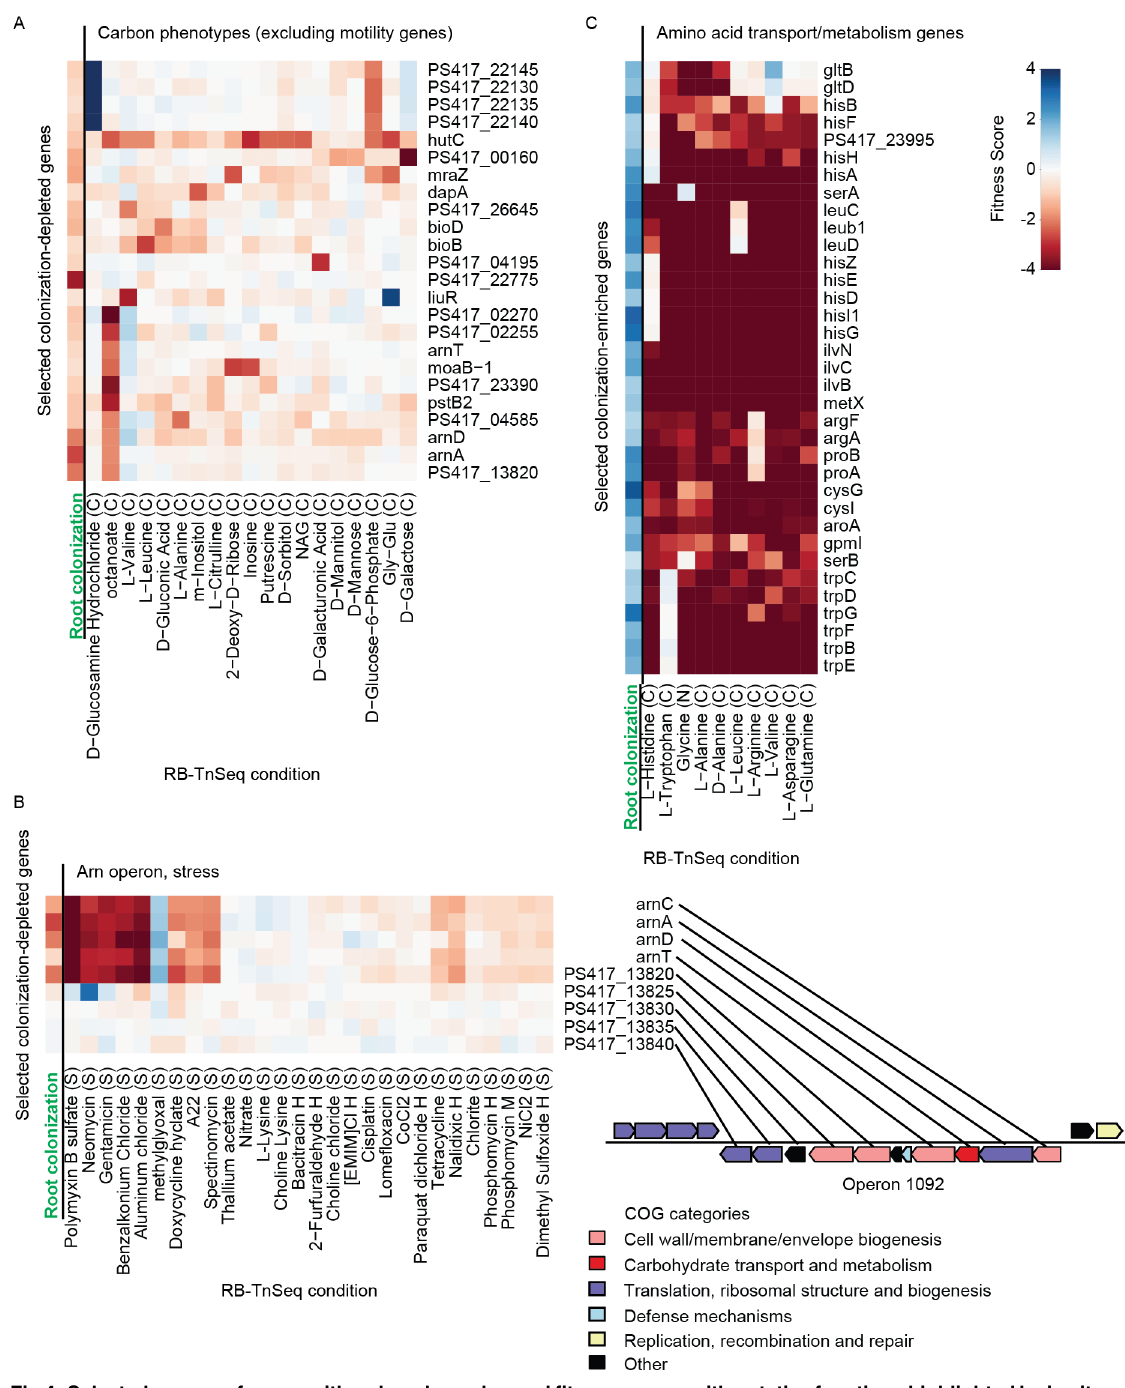
Fig 4. Selected groups of genes with reduced or enhanced fitness scores with putative functions highlighted by in vitro fitness data. Colonization-depleted (A and B) and colonization-enriched(C) geneswere selectedfor their functional characteristics determinedby in vitro growth assays. (A) Genes and in vitro conditions with at least 1 strong phenotype (|fitness score| > 2), excludingany gene with significantly reducedfitness in motility assays. (B) Operon (ID = 1,092) has 5 colonization- depletedgenes, and is also requiredfor resistanceto antibiotics,includingpolymyxin B. (C) Colonization-enrichedgenesthat also have significantly reducedfitness in many in vitro assays (see S8 Fig) with conditions in which the amino acids noted are the only carbon source. These genes have profiles consistent with amino acid auxotrophy. For (A), (B), and (C), gene names are presented on the right, data can be found in S1 Data. Conditions shown are labeledon the bottom. The color scale correspondingto the fitness score is shown at the top right. “Root colonization” (in green) refers to the root fitness score as describedearlier (Results). Abbreviation: COG, cluster of orthologousgroup; RB-TnSeq, randomlybarcodedtransposon mutagenesis sequencing.